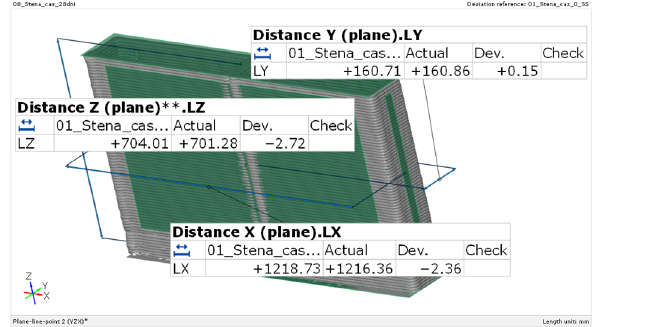
Figure 6. ( a ) Measurement of the dimensions of the wall element by the method of interlacing planes; ( b ) measurement of the dimensions between the fitting planes ( Y direction).